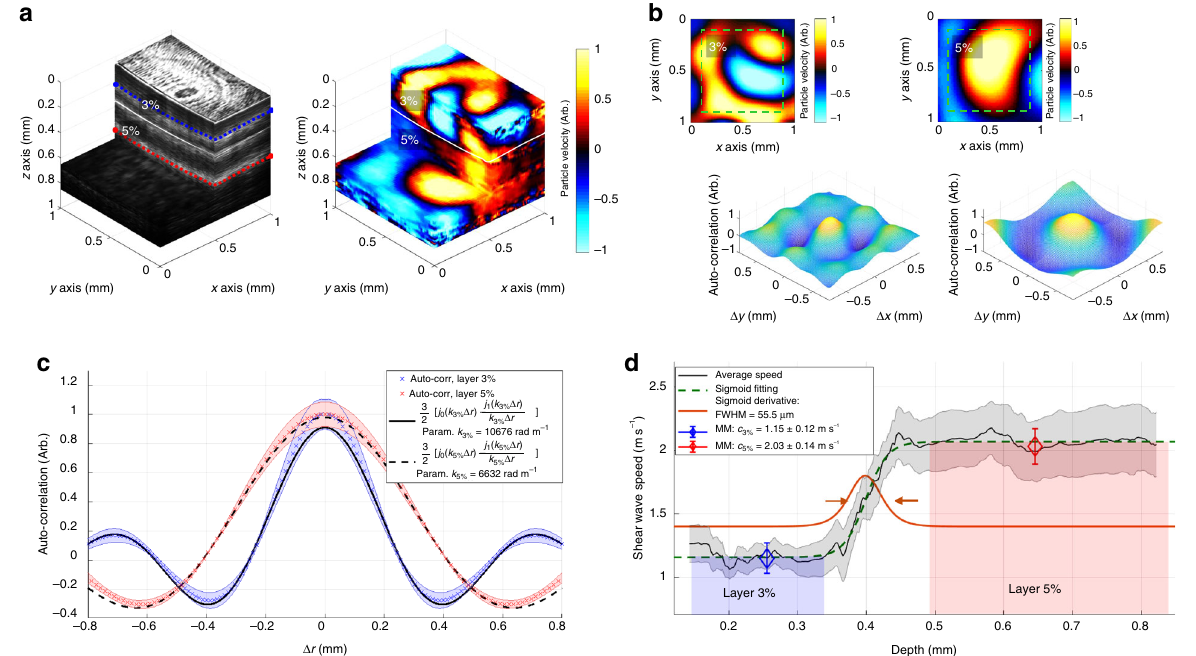
Fig. 3 Axial elastography resolution characterization of Rev3D-OCE. Experimental results of Rev3D-OCE in layered phantoms for axial elastography resolution characterization. a In the left, 3D structural 1 × 1 × 1 mm 3 volume of a horizontally-distributed layer phantom: softer top layer (3% gelatin concentration, ~0.3 mm average tickness), and stiffer bottom layer (5% gelatin concentration, considered semi-in fi nite). Colormap in gray scale represents intensity in arbitrary units. In the right, a reverberant motion volume (particle velocity in arbitrary units) of the same phantom is shown. b Motion frames extracted from motion volume in ( a ) at the 3% region ( z 0 = 0.21 mm, blue dashed cut in ( a )-left), and 5% region ( z 0 = 0.69 mm, red dashed cut in ( a )-left). 2D auto-correlation plots are calculated within a 0.8 × 0.8 mm 2 window of each motion pro fi le. c Average of auto-correlation curves ( N = 360 curves) taken along radial cuts of each 2D auto-correlation plot in ( b ) covering 360 degrees, with shaded regions indicating standard error (SE). Equation (2) is fi tted to each average auto-correlation curve demonstrating a differentiated elasticity between the 3% ( k 3% = 10.68krad m − 1 ) and 5% ( k 5% = 6.63 krad m − 1 ) layers. d Average depth-dependent shear wave speed pro fi le ( N = 5 independent measurements at different regions of the layered phantom) describing the speed transition from the top 3% to the bottom 5% layers. Mean ± SE. The speed pro fi le is fi tted to a sigmoid function (Eq. 5) for the calculation of the average full-width half-maximum layer transition: 55.5 μ m ± 17.3 μ m. Ground truth speed parameters ( c MM c MM 2 : 03 ± 0 : 14 ms (cid:3) 1 ) obtained using mechanical testing ( N = 3 samples per gelatin concentration) show good agreement with the speed pro fi le in 5 % ¼